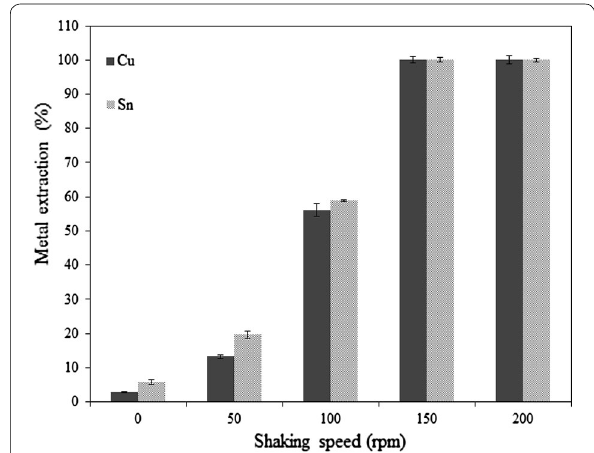
Fig. 3 Effect of shaking speed on metal recovery from Sn–Cu solder (100 mg) by 4 ml acetic acid (80%) at 30 °C temperature and at 30